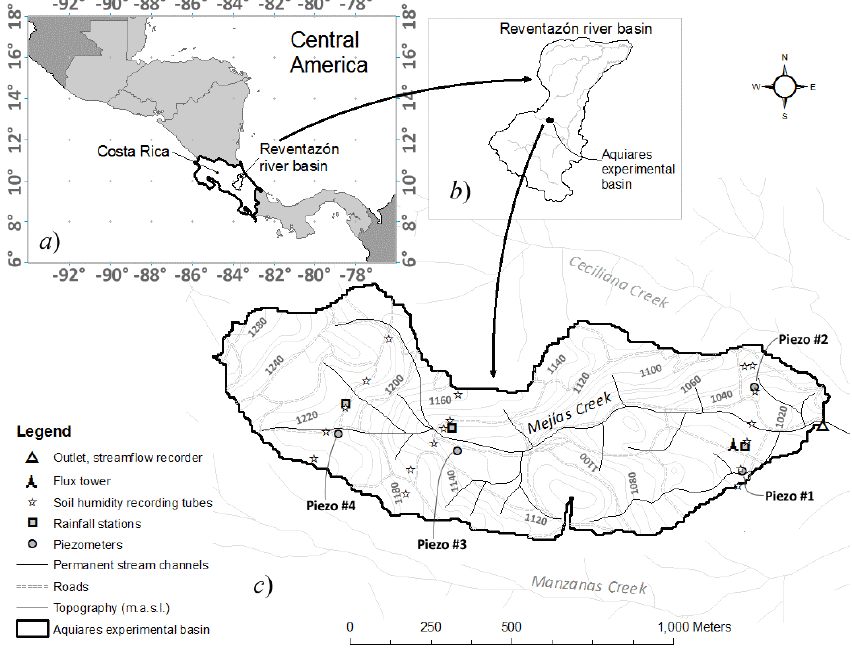
Fig. 1. (a) Location of Reventaz´on river basin in Costa Rica, Central America. (b) Position of experimental basin inside of Reventaz´on basin. (c) The “Coffee-Flux” experimental basin in Aquiares farm and its experimental setup to measure the water balance